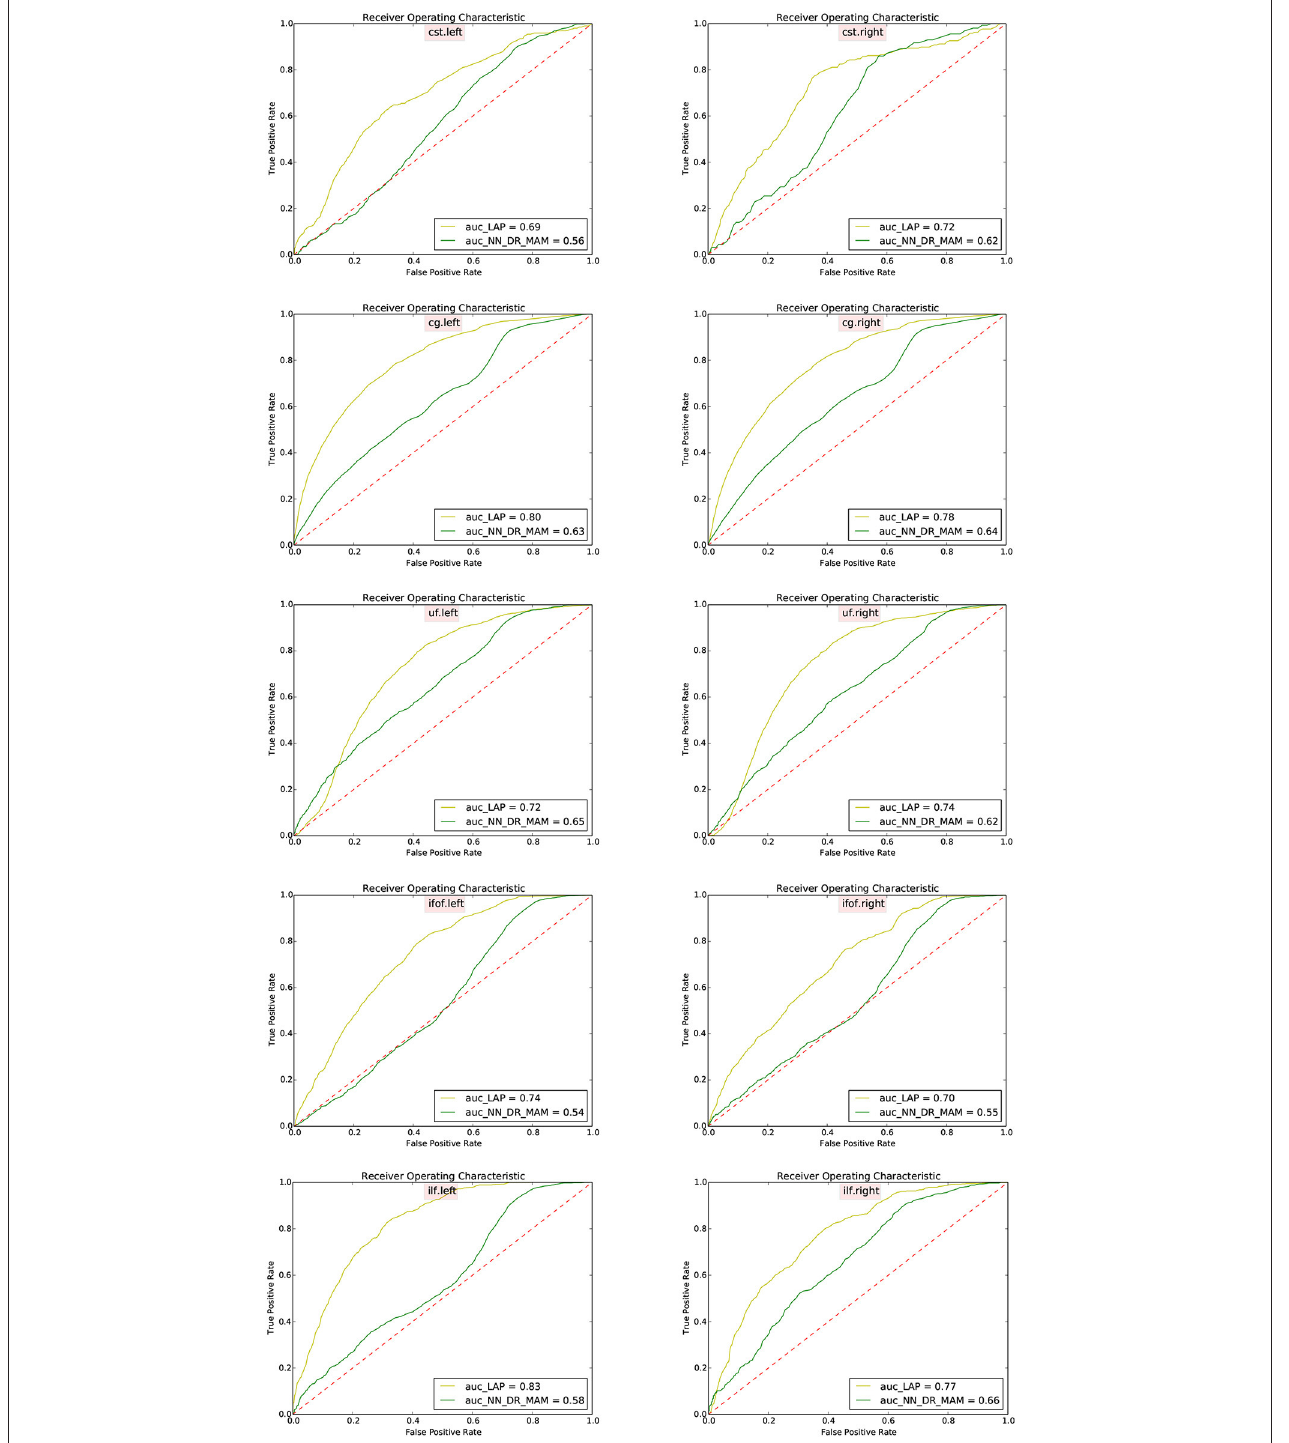
FIGURE 8 | Receiver operating characteristic (ROC) analysis between segmented tracts and ground truth tracts for the NN_DR_MAM and the proposed LAP. Each subfigure shows the average ROC curve for each tract averaged over 15 subjects. For each tract the voxel information has consider for the ROC curve analysis and For each subject different thresholds has